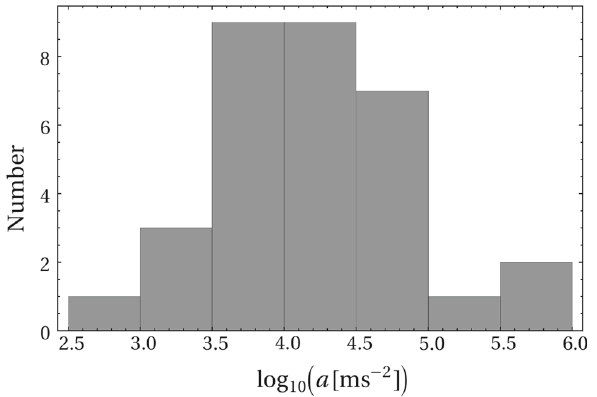
Fig. 7 Correlations between the absolute value of braking index n and the estimated acceleration